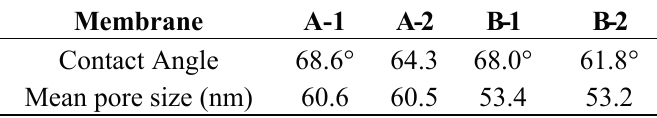
Table 2. Contact angle values of